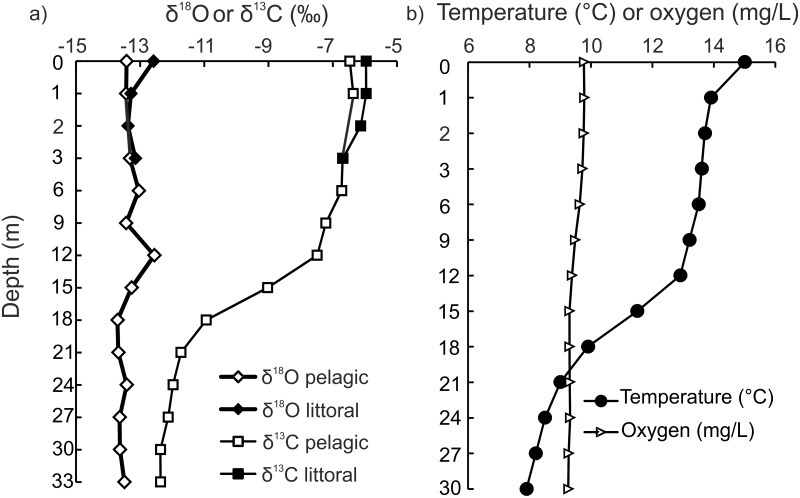
Oxygen (δ18O) and dissolved inorganic carbon (δ13CDIC) stable isotope values and profiles of temperature and oxygen (b) measured from the littoral (0–3 m) and pelagic (0–33 m) water column of Lake Paadar.